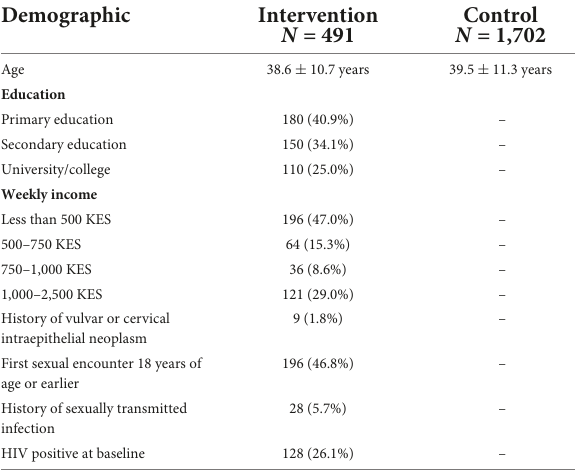
TABLE 1 Cancer tracking system (CATSystem) patient